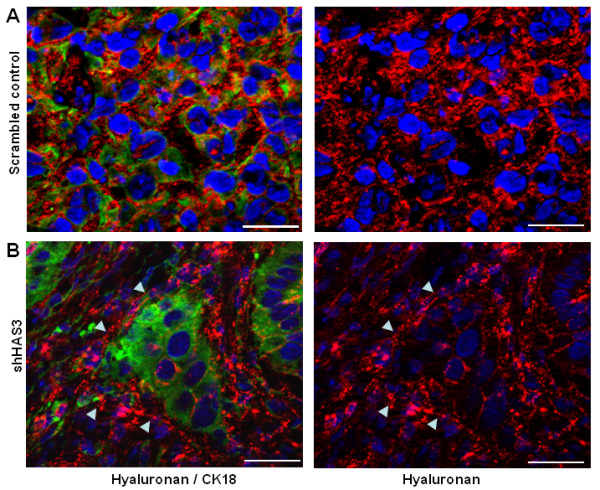
Detection of the distribution of HA in shHAS3 knockdown xenografts by double staining for tumour cells (CK18) and HA. Section from the same series as in Figure 3 were double stained for HA (red) and CK18 (green) to determine the exact location of HA in the xenograft tumour sections. (A) Scrambled control sections revealed a strong HA signal in tumour and stroma. (B) HA staining in shHAS3 samples showed a strong signal in the stroma and tumour/stroma interface (arrows). However, HA was much less pronounced within the tumour cell clusters. Scale bars, 30 μm. Shown are representative images of n = 6 (control) and n = 7 (shHAS3) experiments.